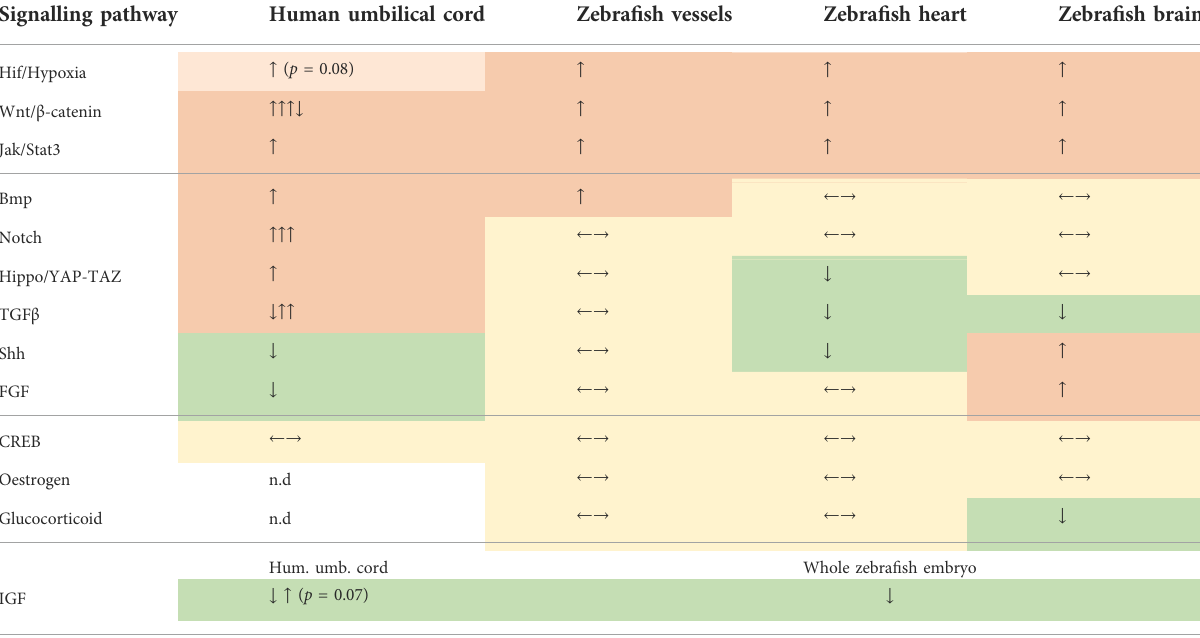
TABLE 2 Summary of the signalling pathway screening in human and zebra fi sh FGR samples. Pathways are grouped, from top down, as: upregulated inbothspecies,differentially regulatedinbothspecies;undetectableor unchanged inbothspecies; downregulated inbothspecies. Signi fi cantly upregulated pathways are indicated by orange colour and up arrow(s). Signi fi cantly downregulated pathways are indicated by green colour and downarrow(s).Unchangedpathwaysareindicatedbyyellowcolourandhorizontalarrows.Multiplearrowsindicatemultiplemarkerstested.Smaller arrows and lighter colour indicate trends (the p value is included). Not detected markers are indicated by n.d. and white